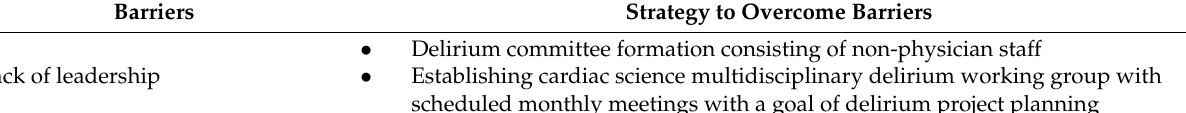
Table 4. Barriers to implementing rPOD intervention at St. Boniface Cardiac Surgery Program.